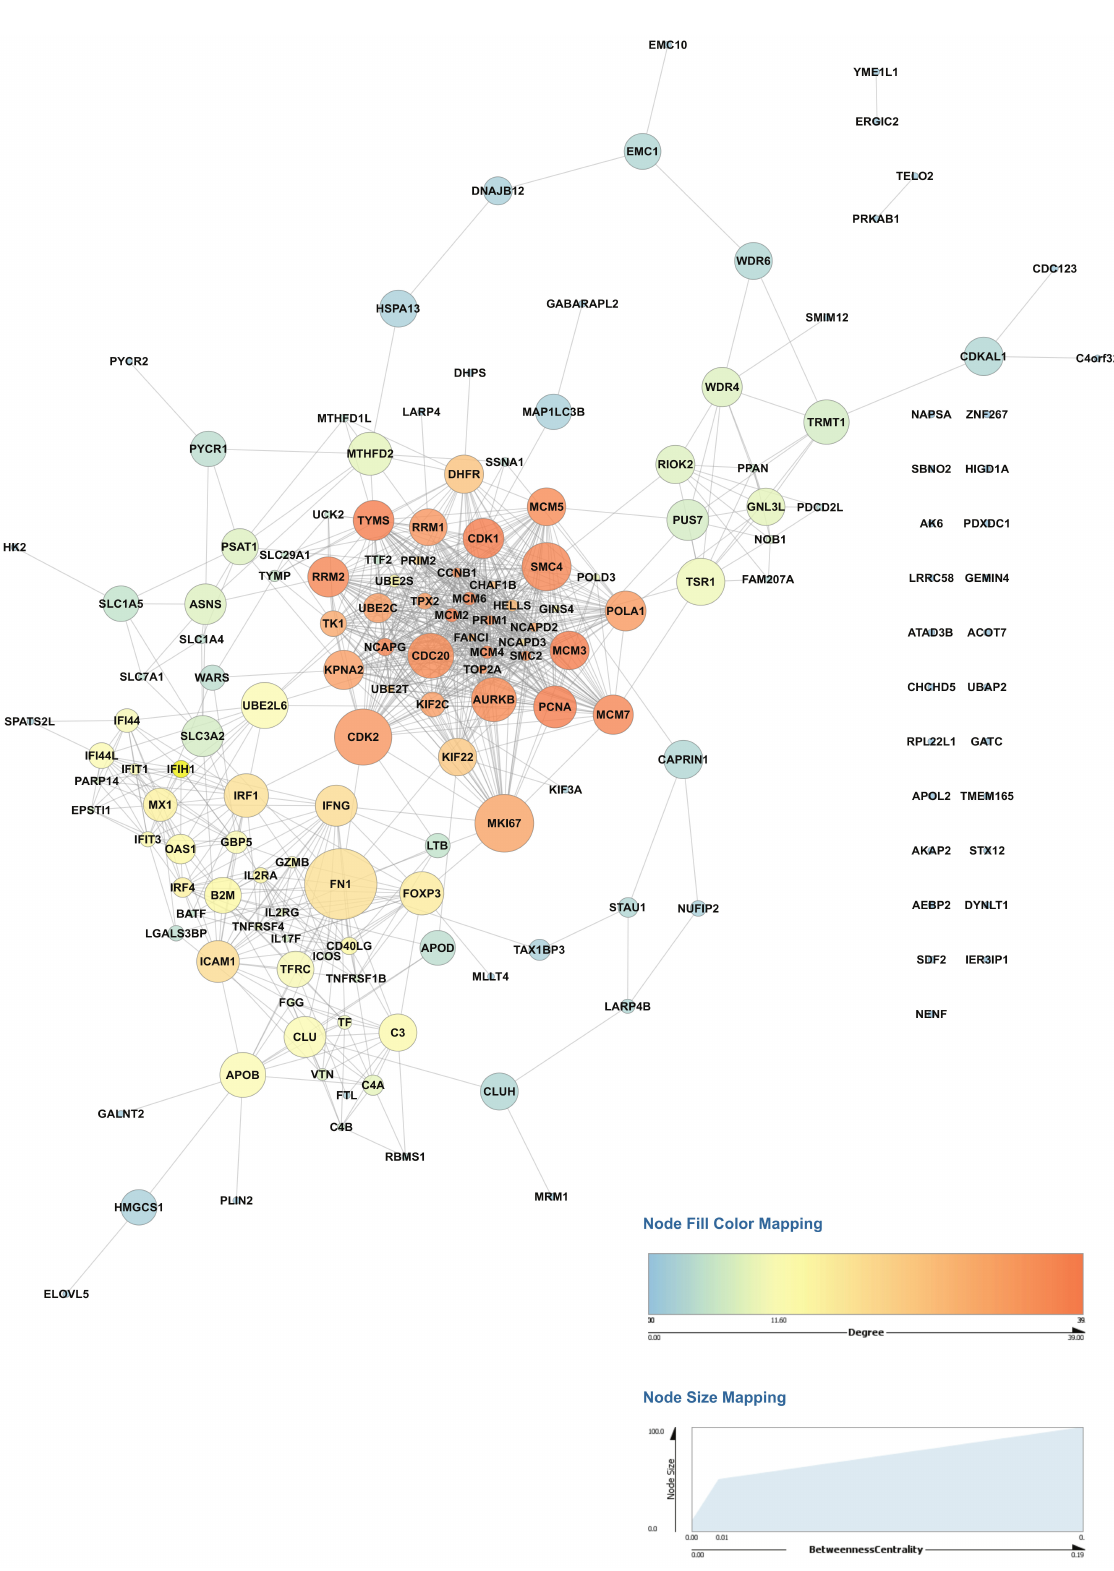
Figure 4. Network analysis of proteins upregulated in primary activated CD4+ T cells in both donors. The Network analysis was carried out using Cytoscape, and network topology properties were calculated using NetworkAnalyzer. The betweenness centrality and degree measures were used to visualize the relationship between nodes. Larger sizes of nodes from high betweenness centrality suggest potential regulatory